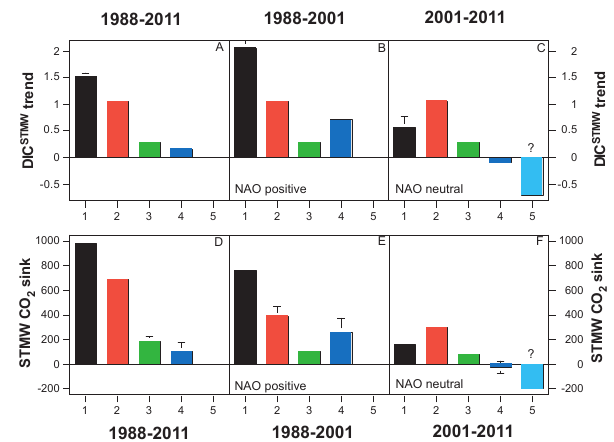
Fig. 5. Trends in DIC STMW ( A–C ; µmolkg − 1 yr − 1 ) and estimates Figure 5 of CO 2 sink into STMW ( D–F ; PgC) for the 1988–2011, 1988– 2001, and 2001–2011 periods. The trend and CO 2 sink in STMW is given in row 1 in each panel ( δ DIC STMW /t ; black). In each panel, row 2 denotes potential uptake due to anthropogenic CO 2 (C ant or δ DIC anthropogenic /t ; red) row 3 denotes increase due to reminer- alization of organic carbon in STMW to CO 2 (i.e. δ DIC biology /t ; green); row 4 denotes increase (decrease) at the STMW outcrop (i.e. δ DIC outcrop /t ; blue); and row 5 denotes the potential change due to mixing of STMW with surface/seasonal thermocline waters (i.e. dDIC mixing /t